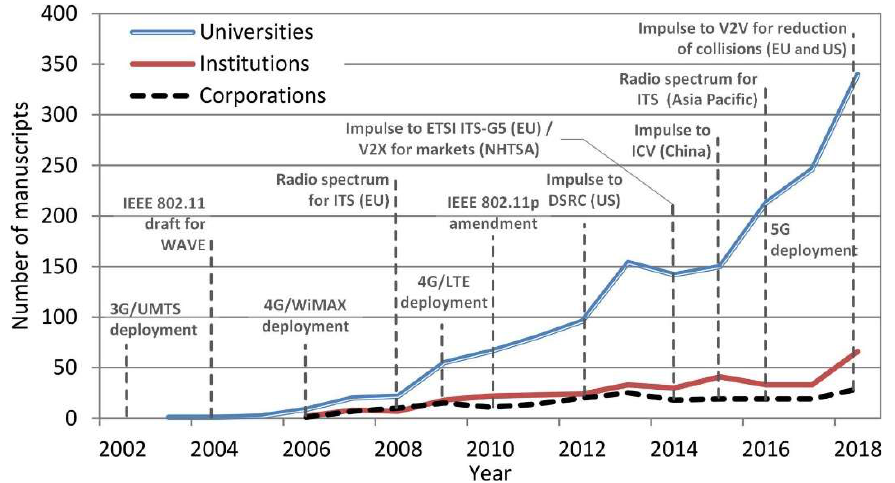
Figure 6. Bibliographic evolution of the contributions on I2X, V2X and P2X research per organization. An analysis on the source type of the publications (Figure 7) shows a major contribution through Table 2. Most productive institutions in I2X, V2X, and P2X research from 1996 to 2018. conferences (62.41%) followed by journals (30.96%) and books (6.62%). The study confirms a good correlation between the di ff erent sources, which suggests that a rapid and strong growth in conferences is also reflected in scientific journals and textbooks ( r 2 = 0.849 and p << 0.05 for “Conference Proceedings” versus “Journals”, r 2 = 0.887 and p << 0.05 for “Conference Proceedings” versus “Book Series”, and r 2 = 0.891 and p << 0.05 for “Book Series” versus “Journals”). The study on the document type found a total of 219 open access manuscripts (6.37%) as well as 41 surveys and short reviews (1.19%) over a total of 3439 manuscripts. These results reflect the weight of primary research versus secondary